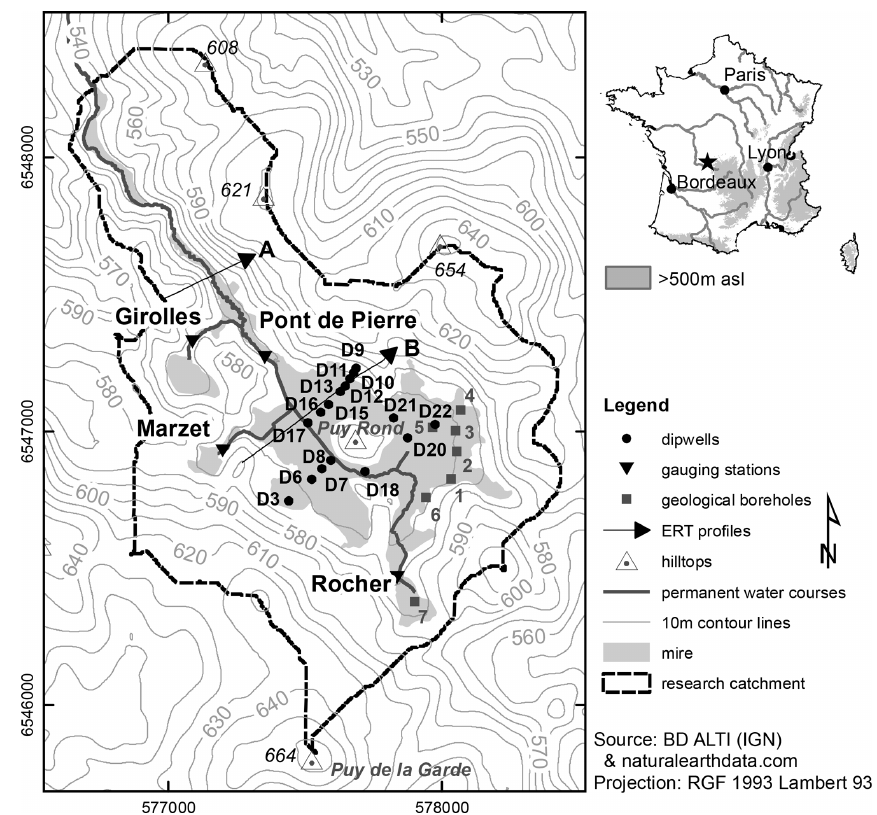
Figure 1. The Dauges mire, its catchment and the hydrological monitoring